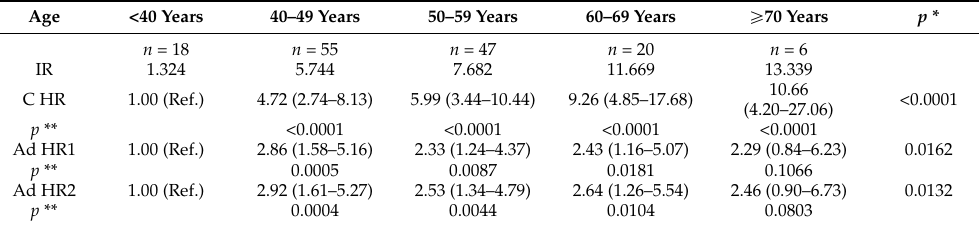
Table 3. An increased risk of chronic kidney disease in women with endometriosis with